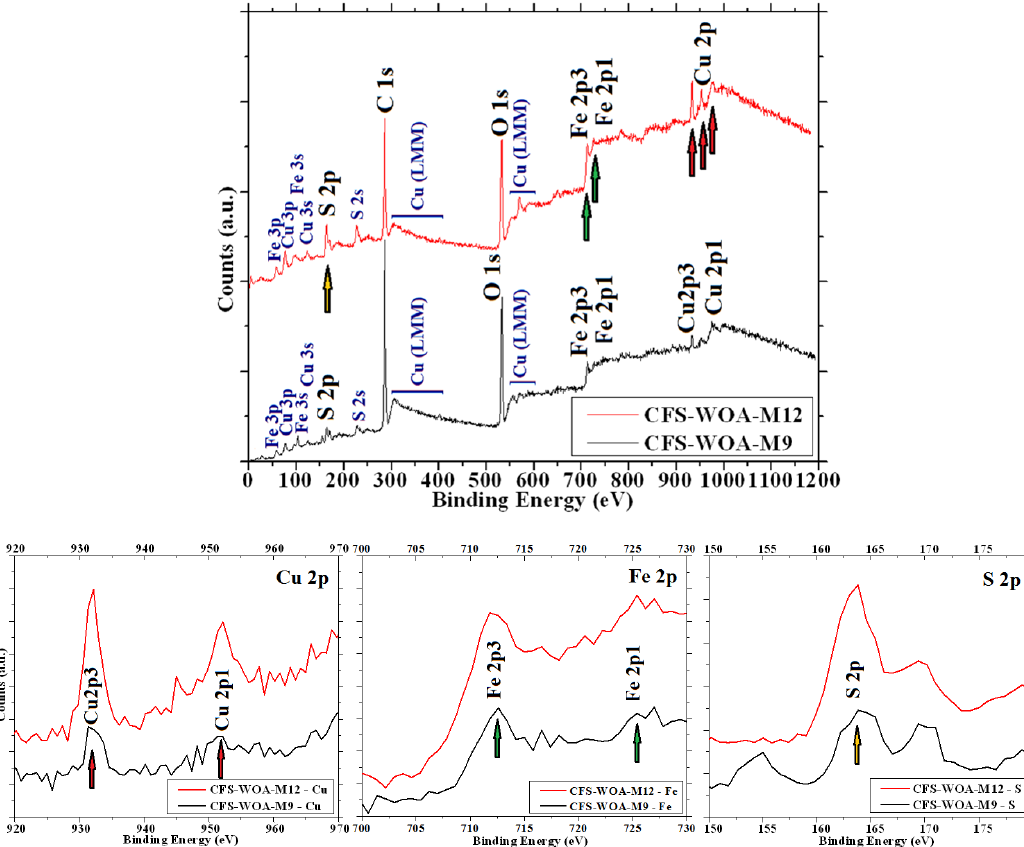
Fig. 5. Whole XPS spectra and high resolution XPS spectra of Cu 2p, Fe 2p, S 2p to of CFS-WOA-M9 (black) and CFS-WOA-M12 (red) compounds.